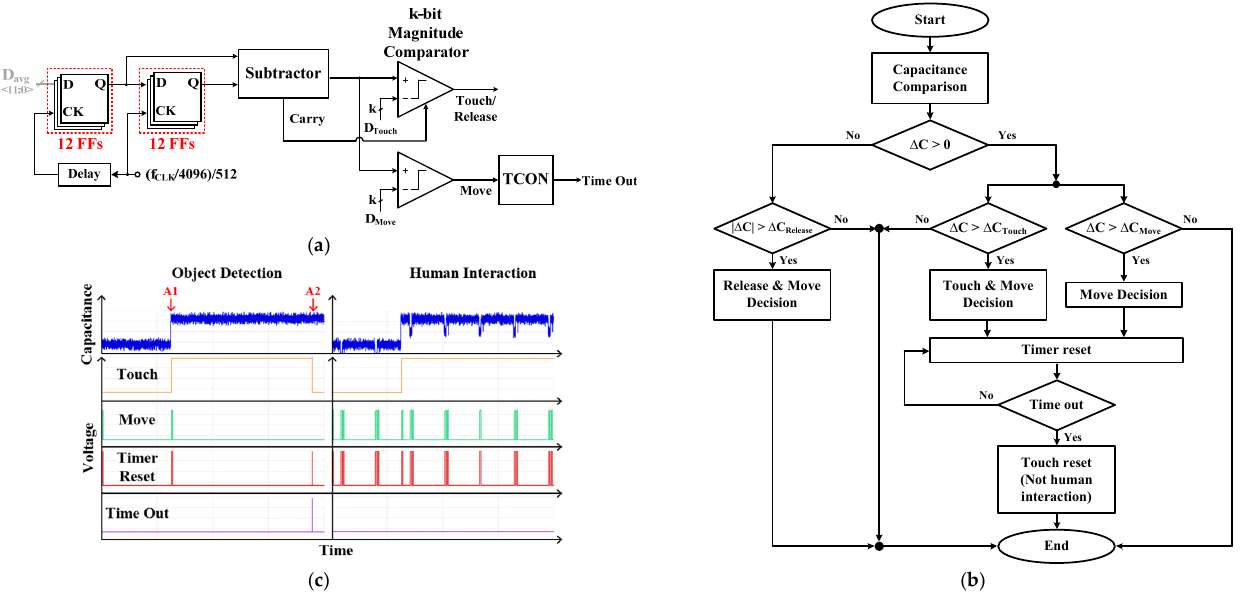
Figure 5. ( a ) The circuit diagram; ( b ) the flowchart of the Δ C detection algorithm; ( c ) Δ C detection algorithm simulation results.